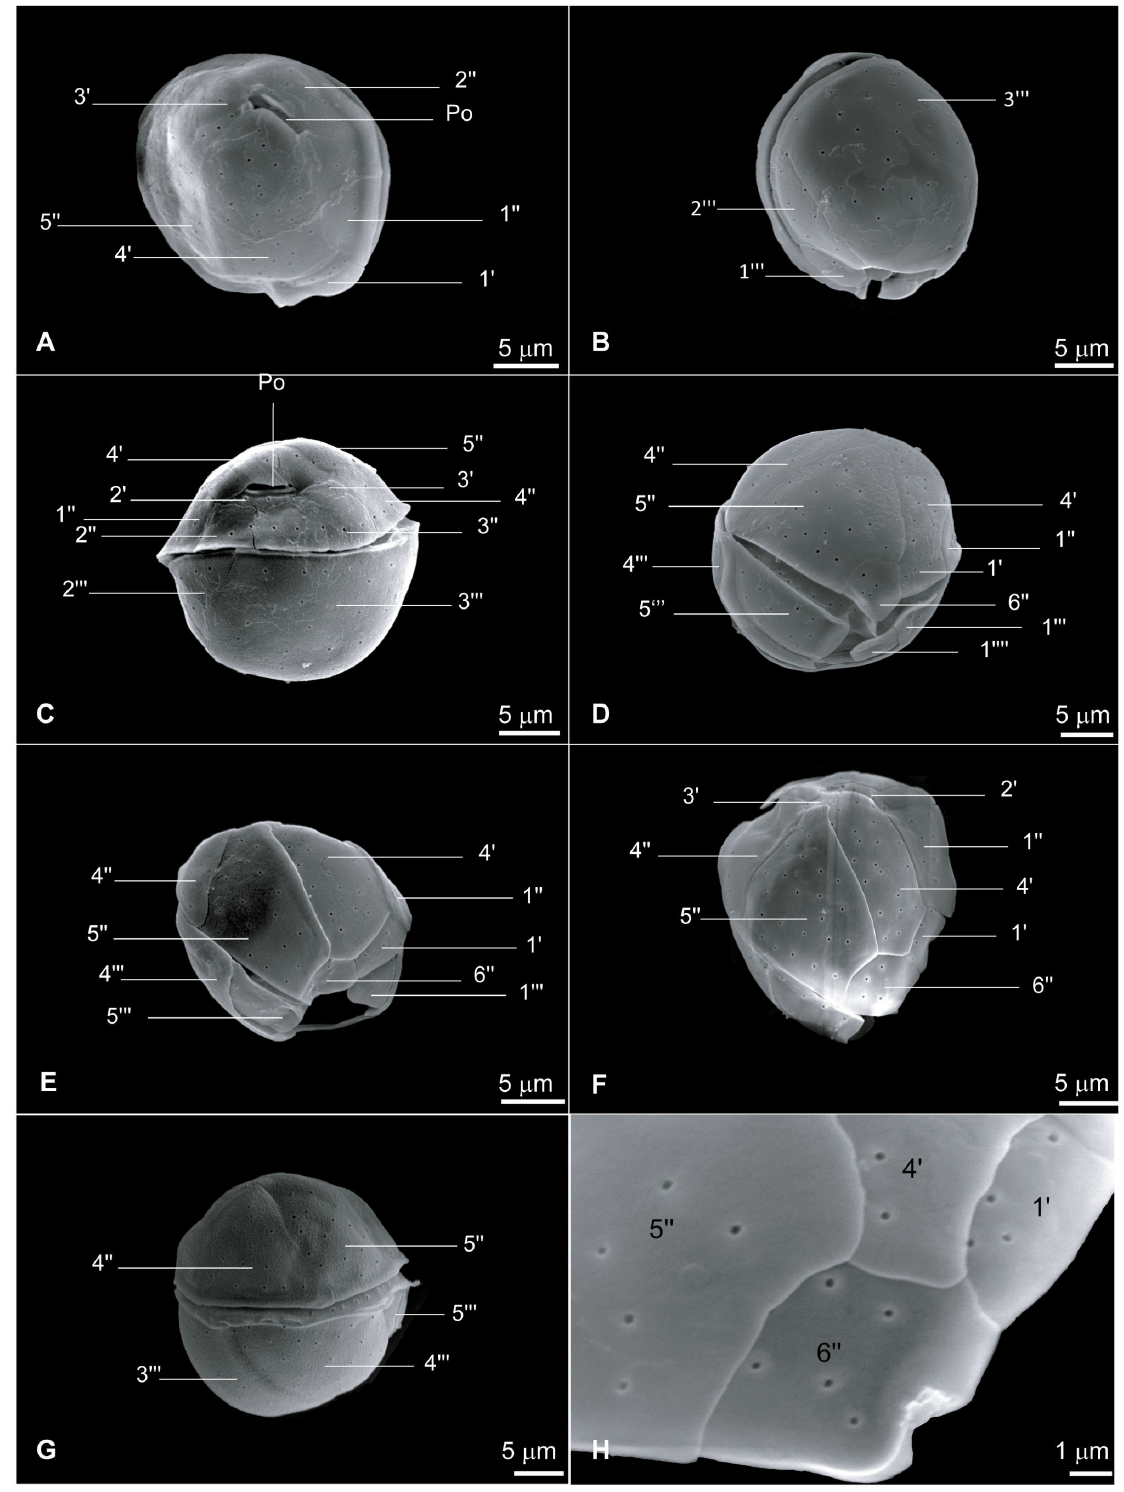
Figure 4. Scanning electron micrographs showing plate arrangements of NQAIF103 , following Besada's plate notations [36]. A: apical view, B: oblique left-antapical view, C: dorsal view, D: ventral view, E: ventral view of the epitheca, F: collapsed epitheca, G: left lateral view, H: detail of the 6'' plate. doi: 10.1371/journal.pone.0079278.g004 PLOS ONE | www.plosone.org 5 October 2013 | Volume 8 | Issue 10 |